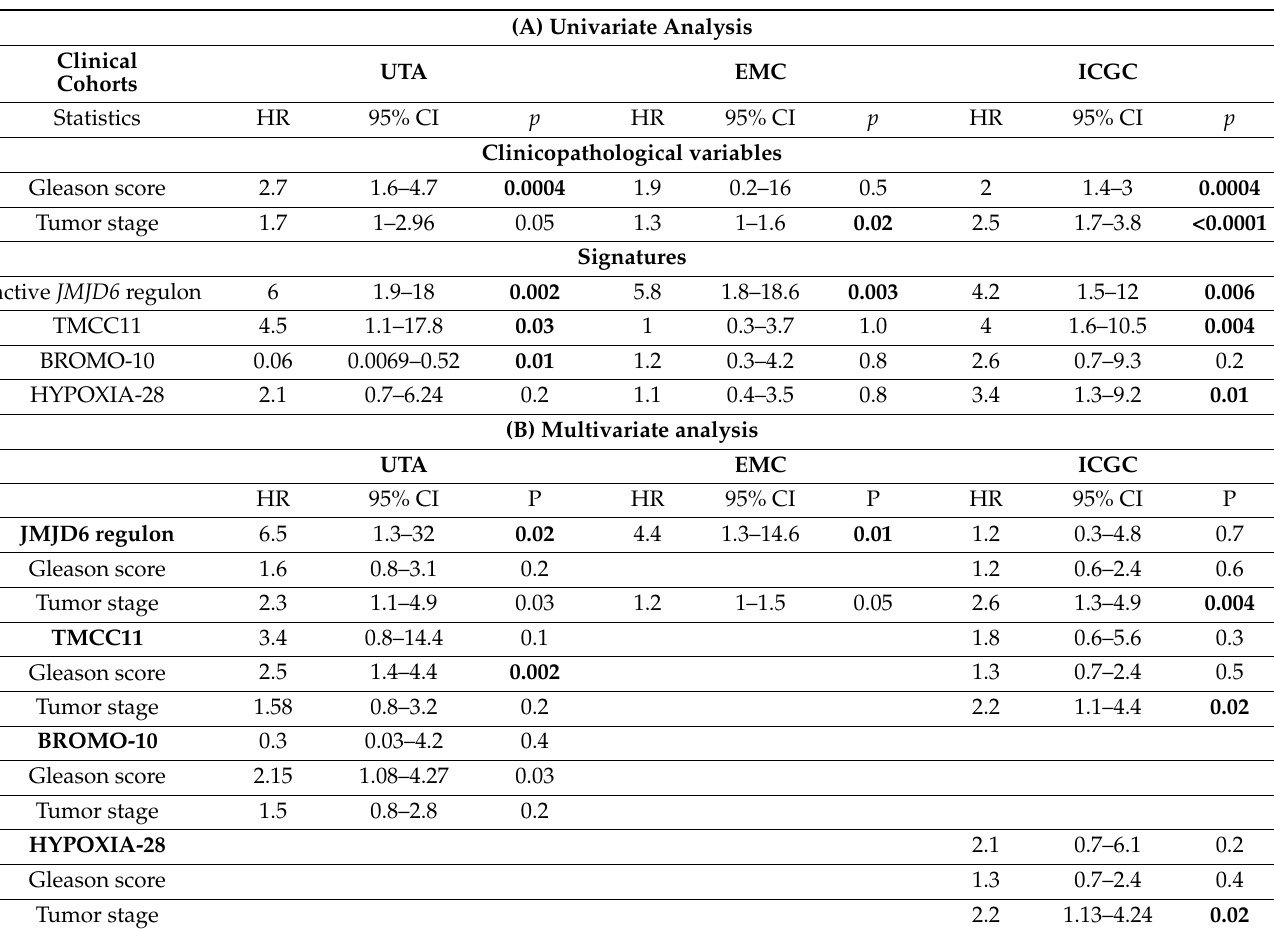
Table 3. Cox regression univariate ( A ) and multivariate ( B ) survival analysis. p -values (P), Hazard ratios (HR) and 95% Confidence intervals (CI) are showed for each univariate regression. Multivariate analysis results, using Gleason score and/or tumour stage as covariates, are shown only for the variables whose association with biochemical recurrence was significant ( p < 0.05) at univariate level. All significant p -values are highlighted in